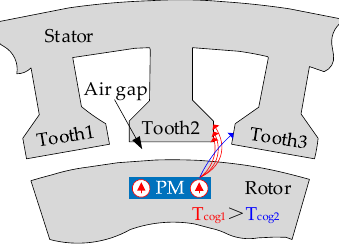
Figure 5. Schematic of the cogging torque generation mechanism.